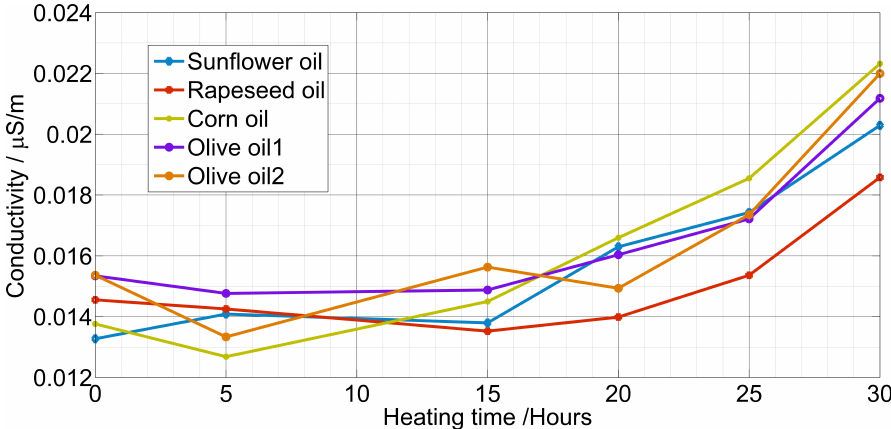
Figure 6. Measured conductivity at 10 kHz vs. the heating time.